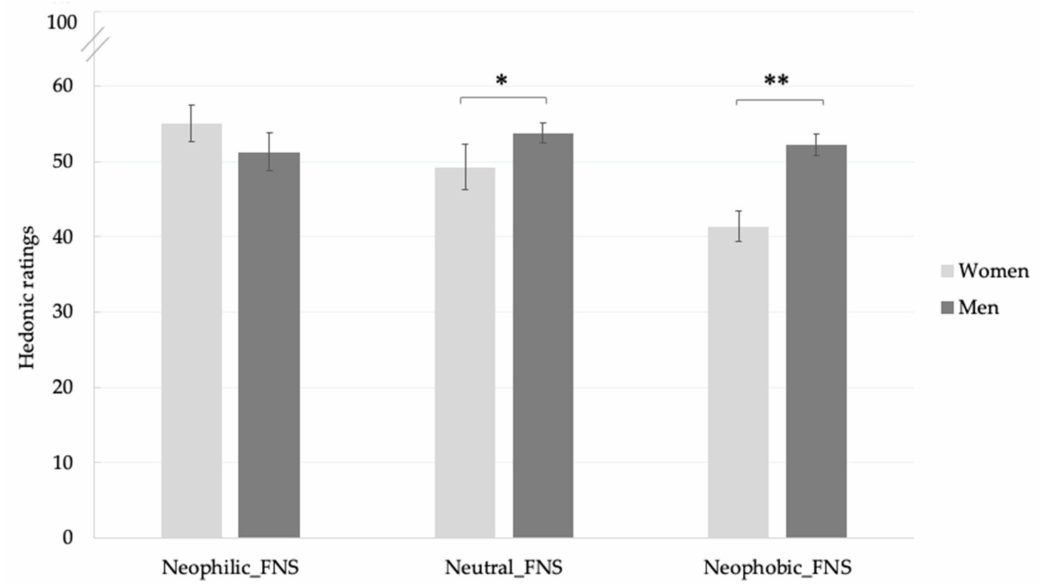
Figure 4. Mean liking scores ± SEM according to food neophobia levels and gender. * p < 0.05; ** p < 0.01. FNS = Food Neophobia